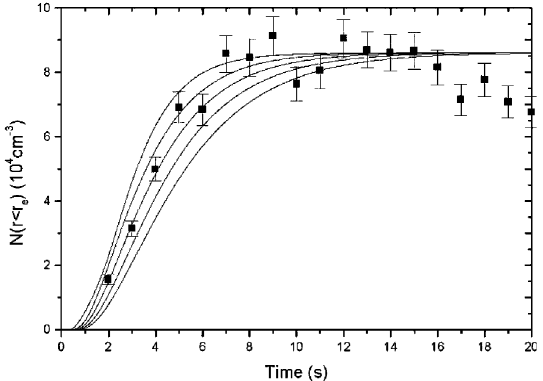
FIG. 5. The simulation results for the evolution of bare Mo ions inside the EBITwith machine parameters as described in the main text. The evolutions were calculated using different values for the beam radius as described in the text. The lines (from slowest to fastest onset) correspond to a beam radius of 66, 62, 58, 52, and 48 (cid:8) m , respectively. The symbols ‘‘ j ’’ are the experimental data with the errors being determined statistically. simulations.